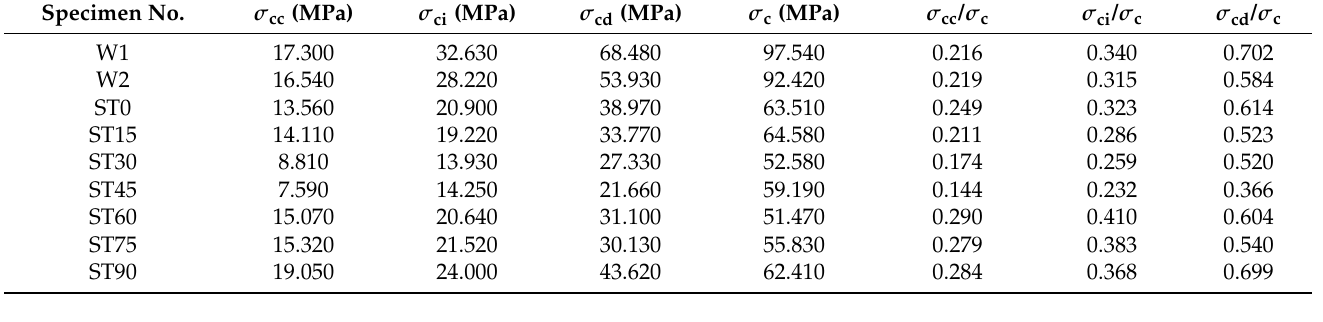
Table 3. Summary of sandstone progressive failure thresholds under hydro-mechanical coupling.